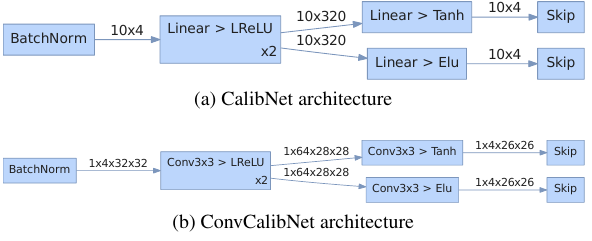
Figure 19. Modifications of the proposed network to include a second output corresponding to the variance of the